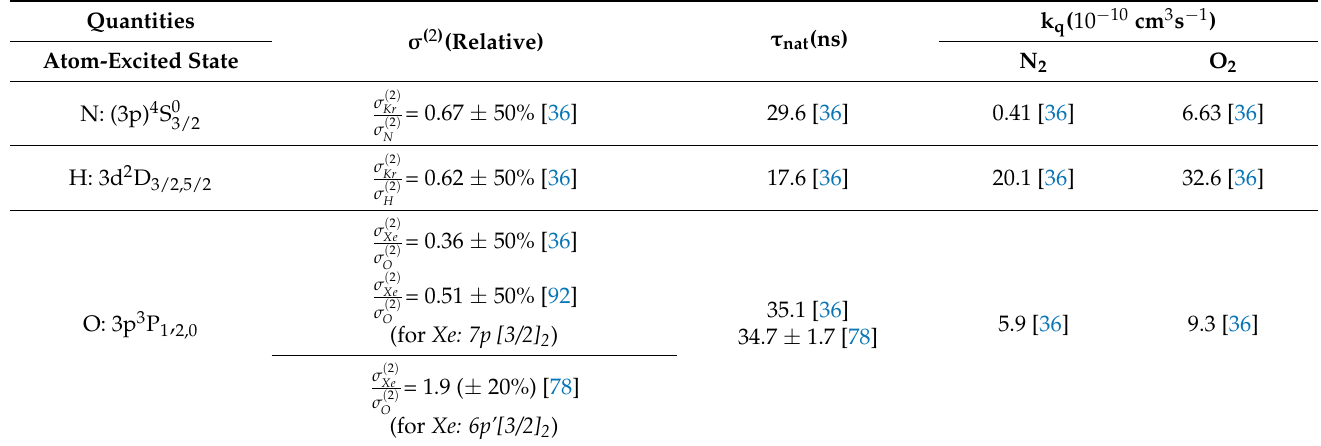
Figure 4. Upper figure. Two − photon excitation schemes for atomic hydrogen (H), nitrogen (N), and oxygen (O). Lower figure. Two photon excitation schemes of noble gases: krypton (used for H– and N–atom density calibration) and xenon (used for O–atom density calibration). Table 3. Relative cross-section values, typical natural lifetimes, and quenching coefficients (two common quenchers, N 2 and O 2 , are given; for more species see references [34,78]) for reactive (H, N, O) and calibrating (Kr, Xe) atomic species commonly used in TALIF